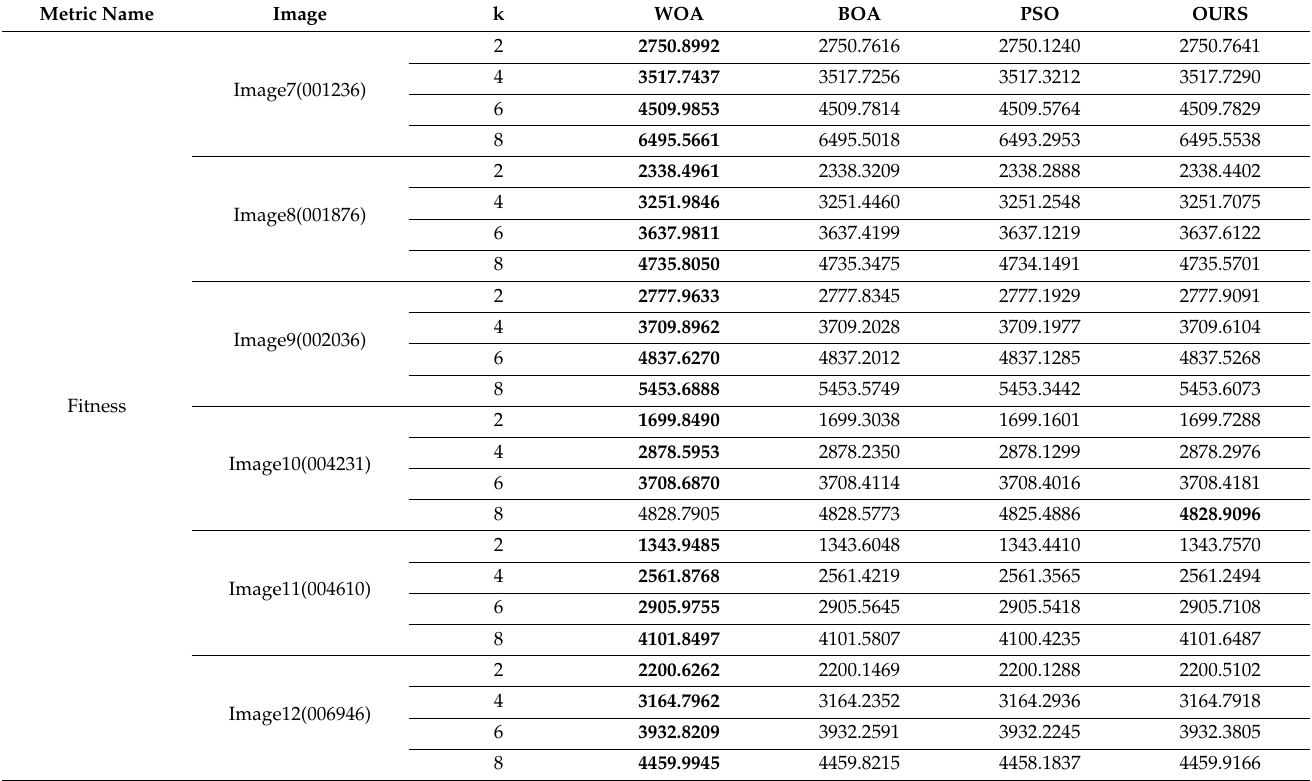
Table 10. Comparison of Fitness in Images